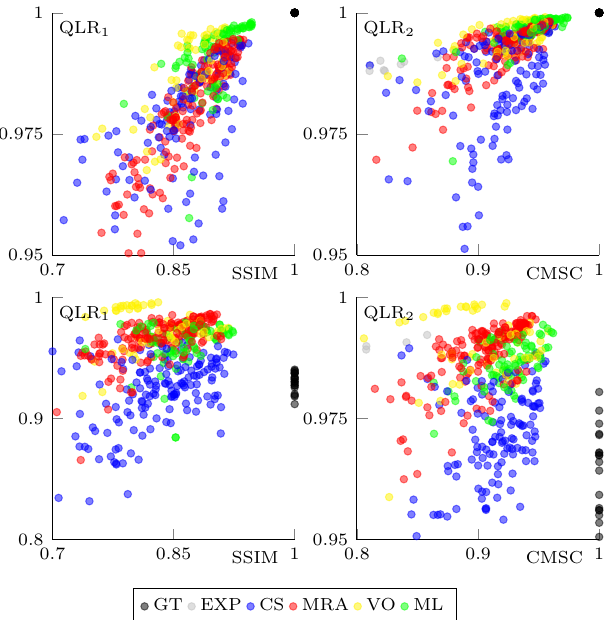
Figure 5. From left to right, QLR 1 vs. SSIM and QLR 2 vs. CMSC on the WorldView-2 RR dataset. Both the “aligned” ( top ) and “misaligned” ( bottom ) dataset cases are shown. Each marker is associated with a single pansharpening result on a 512 512 tile. Black markers correspond to × the ground truth. Light gray ones (EXP) correspond to a simple interpolation. The remaining clusters correspond to the different algorithms grouped by